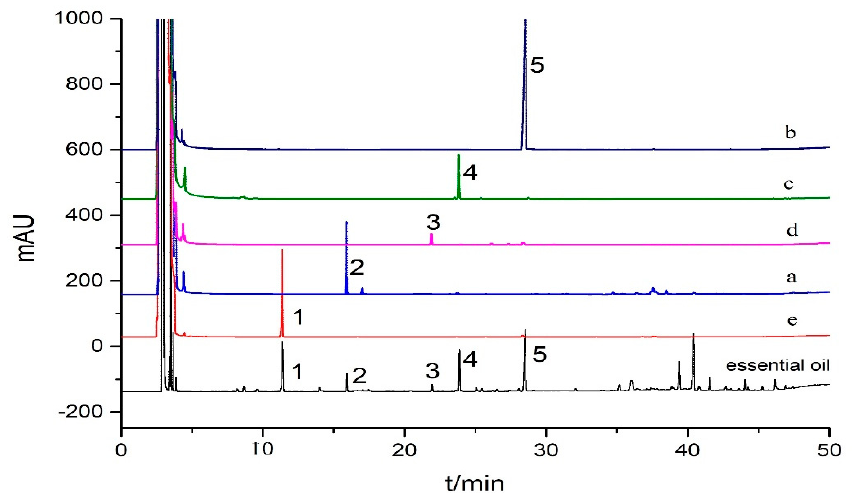
Figure 5. GC chromatograms of compounds separated from Curcuma wenyujin Y.H. Chen et C. Ling essential oil by HSCCC separation. Table 3. The partition coefficient values of compounds.